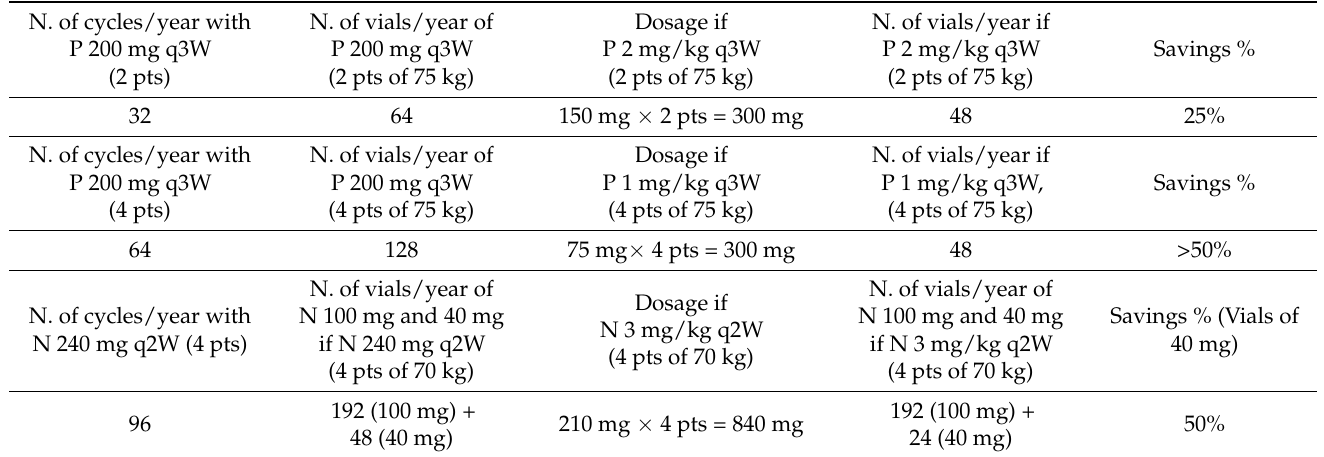
Table 1. Examples of savings with low-dose immunotherapy versus flat-dose